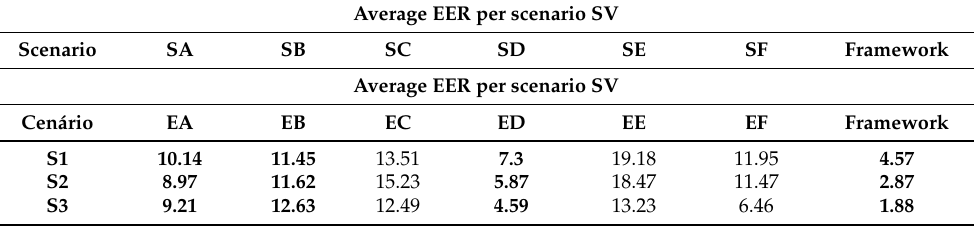
Table 11. Average EER per scenario